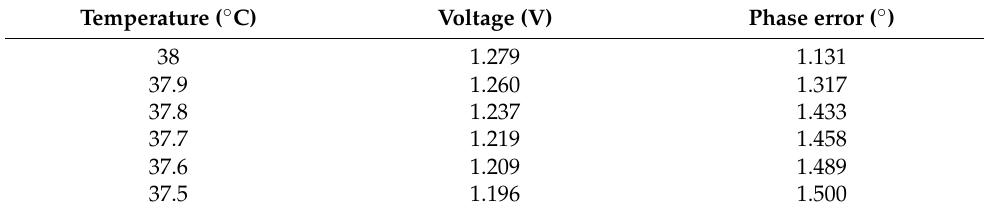
Figure 20. Corrected result of Q channel using correction algorithm. The corrected results are shown in Table 5. Table 5. Voltage and phase error after correcting phase error, gain error and offset